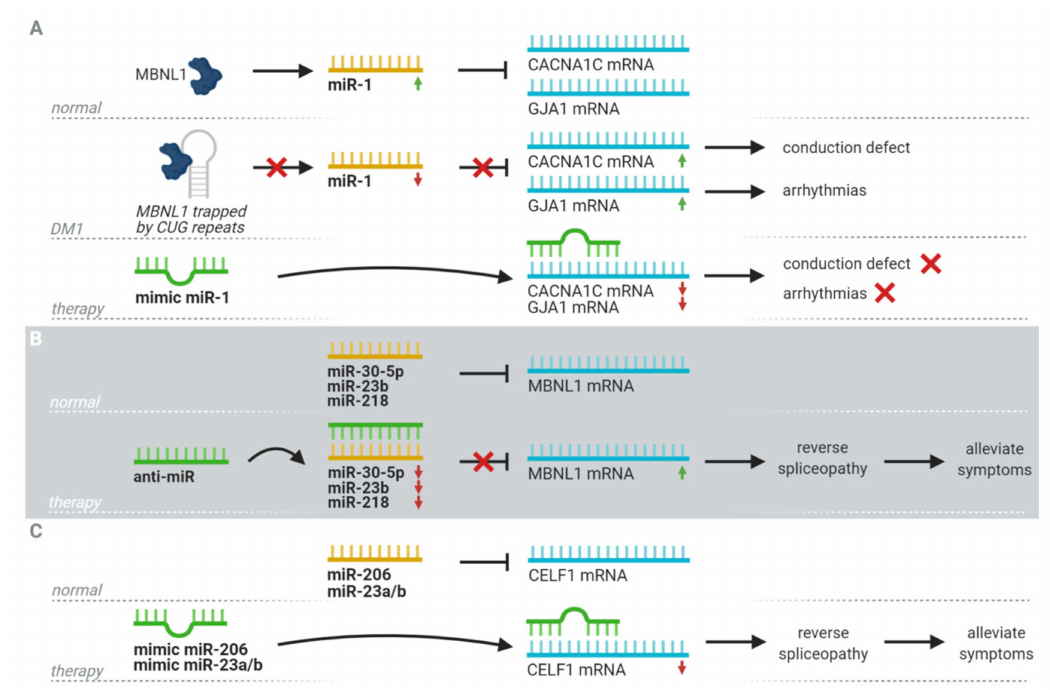
Figure 2. An overview of the suggested therapeutic potential of miRNAs in Myotonic Dystrophy type I (DM1) by targeting downstream targets of MBNL1, upregulating mRNA levels of MBNL1, or downregulating mRNA levels of CELF1 by the use of miRNA mimics or anti-miRs. ( A ) The use of an miR-1 mimic to circumvent the detrimental e ff ect of MBNL1 sequestration, resulting in a downregulation of downstream targets and symptom alleviation. ( B ) The use of an anti-miR for miRNA inhibitors of MBNL1 to increase expression levels in DM1 and alleviate symptoms. ( C ) The use of a miRNA mimic of inhibitors of CELF1 to reduce its expression and alleviate symptoms in DM1. MBNL1 = muscleblind-like 1, CELF1 = CUG-BP and ETR-3-like factors family member 1, CACNA1C = Voltage-dependent L-type calcium channel subunit alpha-1C, GJA1 = connexin 43. Created with